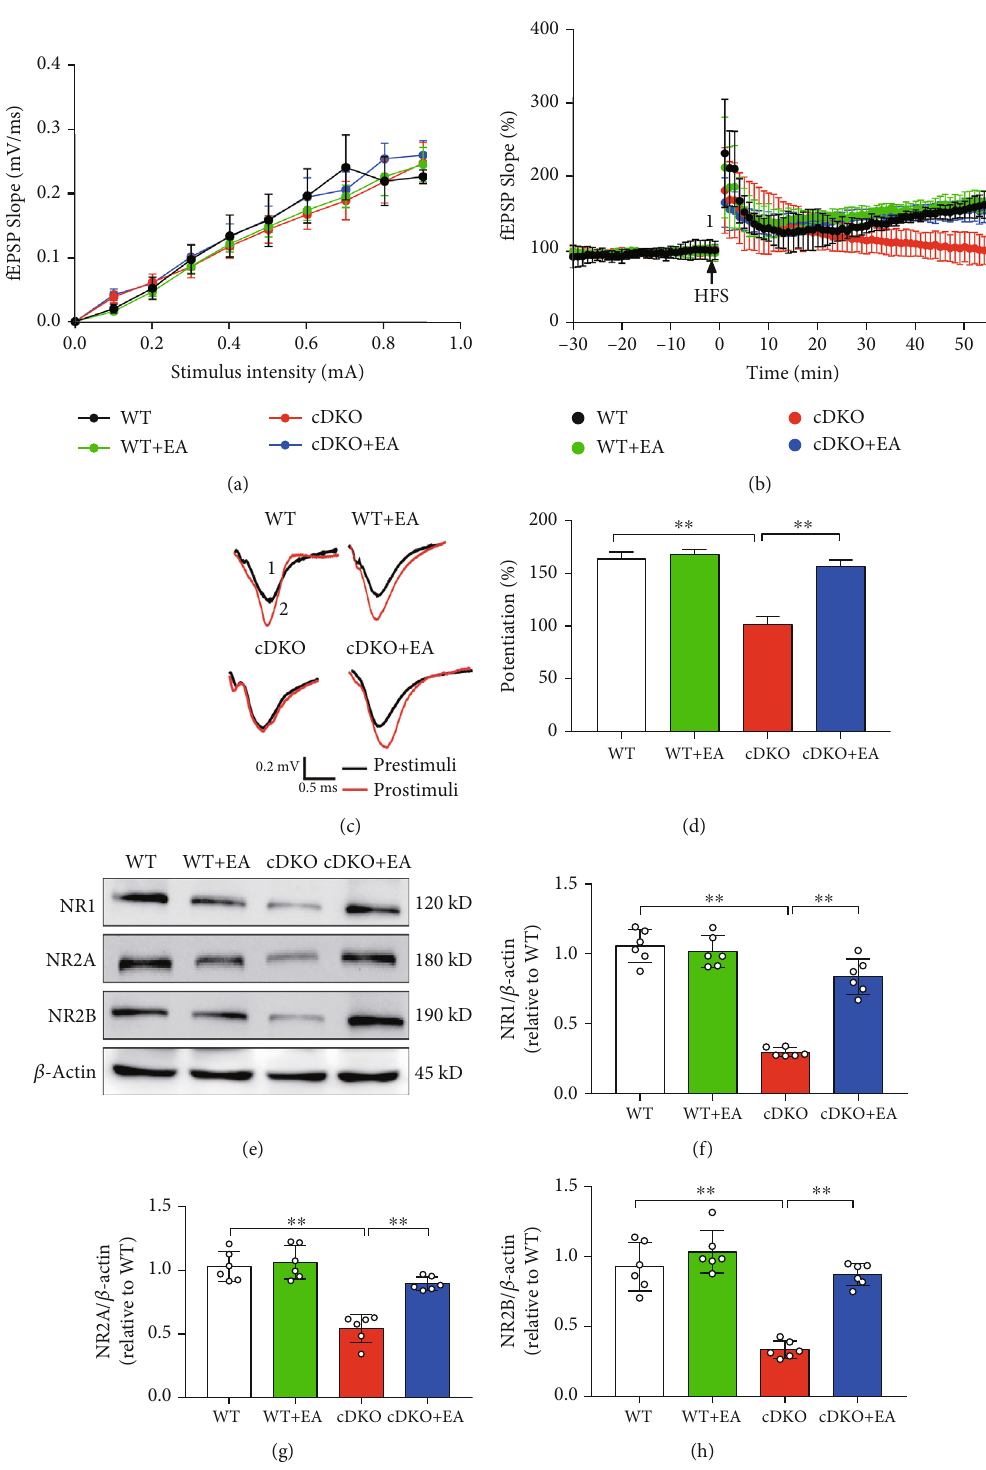
Figure 2: EA treatment improves impaired LTP at SC-CA1 synapses and level of NMDA receptors in the hippocampus of PS cDKO mice. (a) Quantitative data of I/O curves obtained at di ff erent stimulus intensities. (b) Normalized fEPSP slopes in SC-CA1 synapses from hippocampal slices of indicated mice. (c) Representative fEPSP traces taken before (1, black lines) and 60 min after tetanus stimulation (2, red lines) from each group. Scale bar: 0.5mV, 10ms. (d) Quantitative data of potentiation at 60min after tetanus stimulation ( n = 7 slices from 5 mice for each group). (e) Representative Western blot of synapse-associated proteins in the hippocampus. (f) – (h) Quanti fi cation of Western blot of the synapse-associated proteins in the hippocampus ( n = 6 mice for each group). The levels of synapse-associated proteins were standardized based on the respective level of β -actin. The values were expressed as relative changes to the respective WT mice, which was set to 1. Data are the mean ± S : E : M : , ∗ p < 0 : 05 , ∗∗ p < 0 : 01